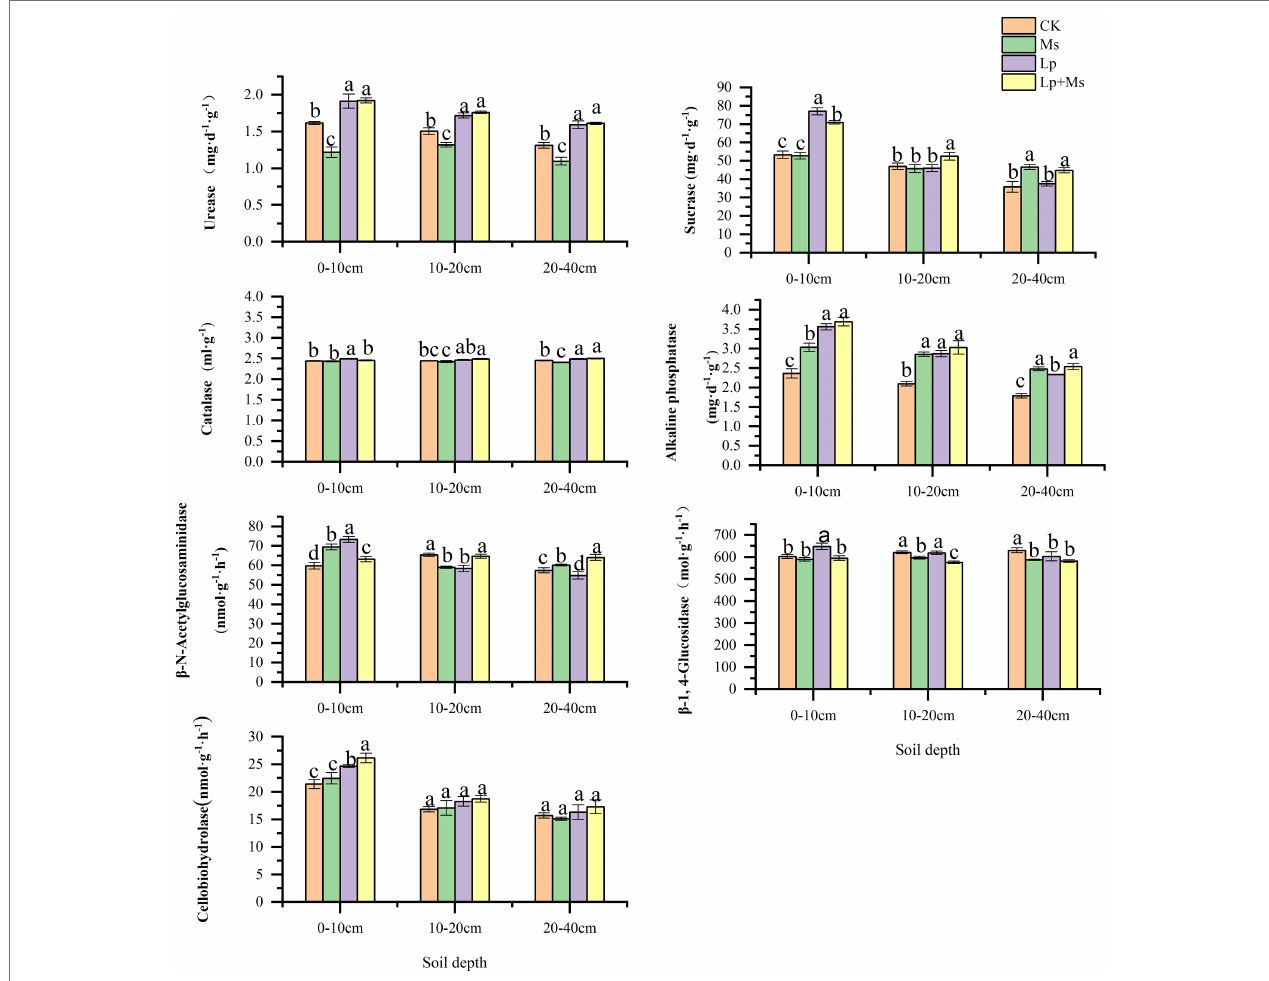
FIGURE 2 | Effects of intercropping grass on enzyme activities in different soil layers. Different lowercase letters in the figure indicate significant ( P < 0.05).